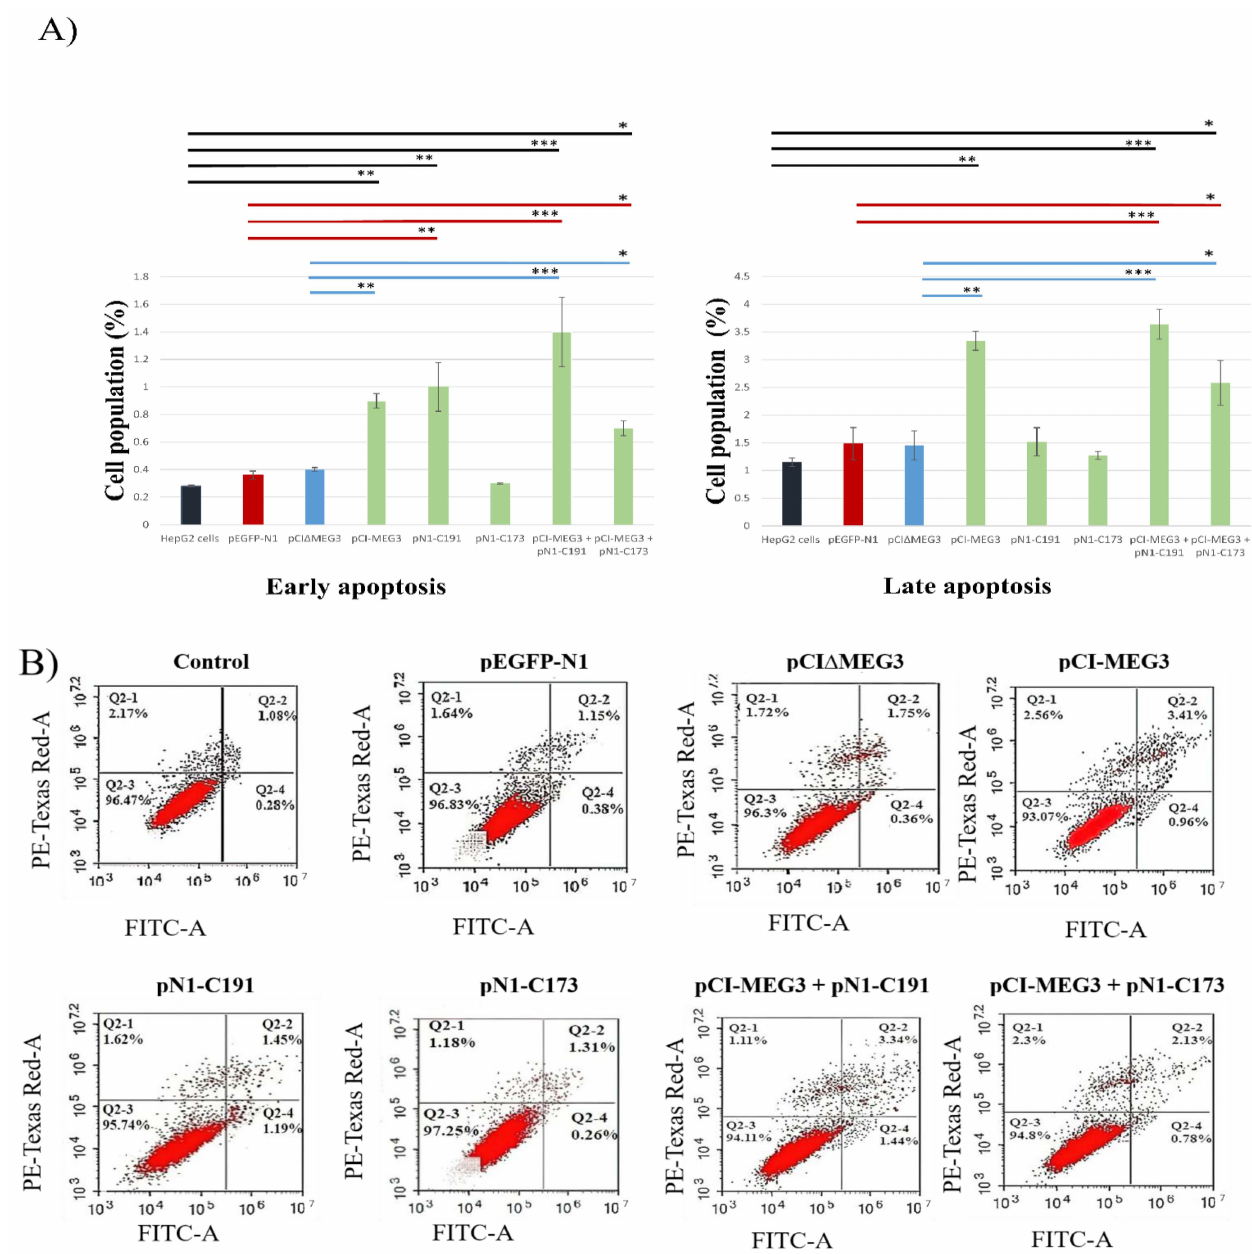
Figure 2. ( A ) Cell death mechanism in HepG2 after transfection with different vectors. Cells were exposed to transfection for 72 h. Percentages of cells undergoing apoptosis/necrosis were assessed using Annexin-V/FITC-PI staining compared to control cells. The chart of flow cytometry results is divided into four gates; Q2-1 represented necrosis, Q2-2 represented late apoptosis, Q2-3 represented intact normal cells, and Q2-4 represented early apoptosis, as shown in the figure. Colored lines represent the significance of apoptosis in HepG2 cells between each sample and its control. Controls are divided into (a) HepG2 cells (Black), (b) HepG2 cells transfected with pEGFP-N1 (Red), and (c) HepG2 cells transfected with pCI ∆ MEG3 (Blue). ( B ) Quantification of the stages of cell death after transfection with different plasmids. Data presented as mean ± SD. (*) shows the p -value < 0.05, (**) shows the p -value < 0.01 and (***) shows p -value < 0.001 compared to control untransfected HepG2 cells, pEGFP-N1 and pCI ∆